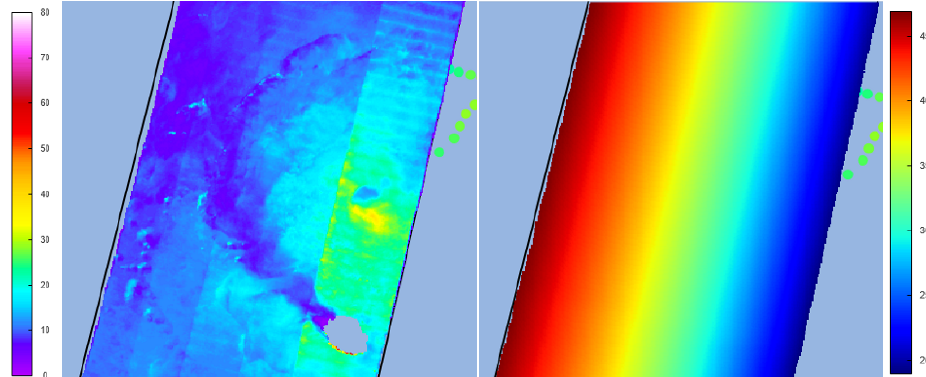
Figure 7. S1A 3-km wind speed product ( left image) and incidence angle ( right image) for 7 February 2017 at 01:54:00Z with TC CARLOS. Units are m · s − 1 for wind speed and degrees for incidence angle. This image/product was obtained from Ifremer/Cyclobs and produced with SAR wind processor co-developed by IFREMER and CLS.